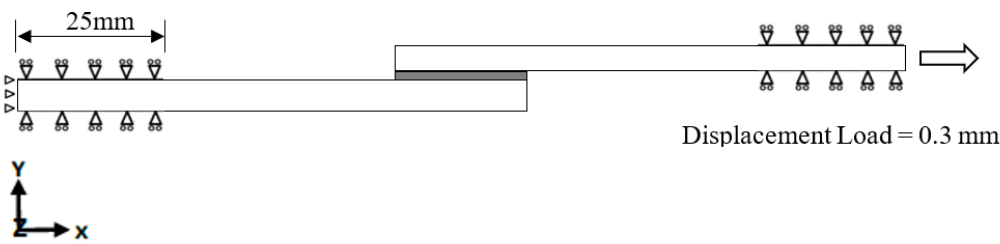
Figure 2. Boundary and Loading Conditions on Single-Lap Joint, SLJ (Not to Scale).